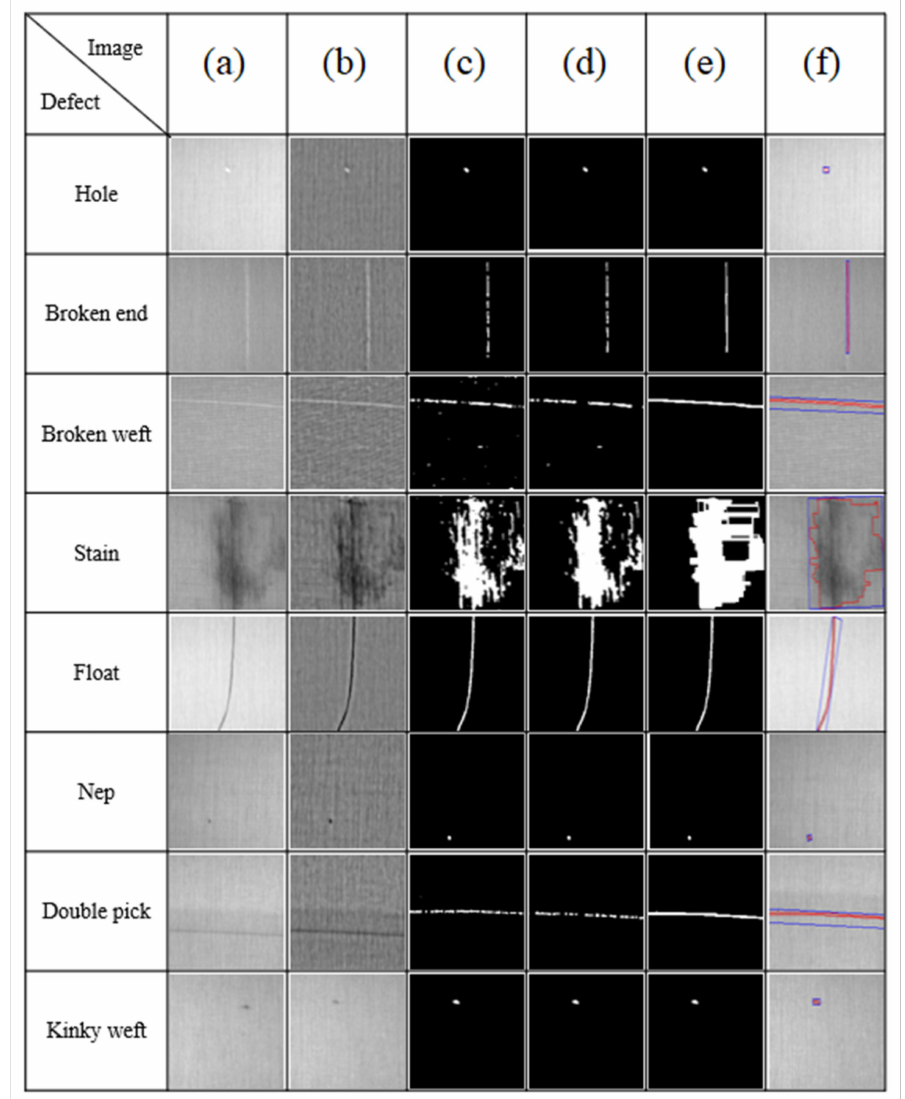
Figure 11. The image segmentation demonstration: ( a ) Original image; ( b ) Image preprocessing; ( c ) Binarization split image; ( d ) Smaller area filter out; ( e ) Morphology closed operation; ( f ) con- tour